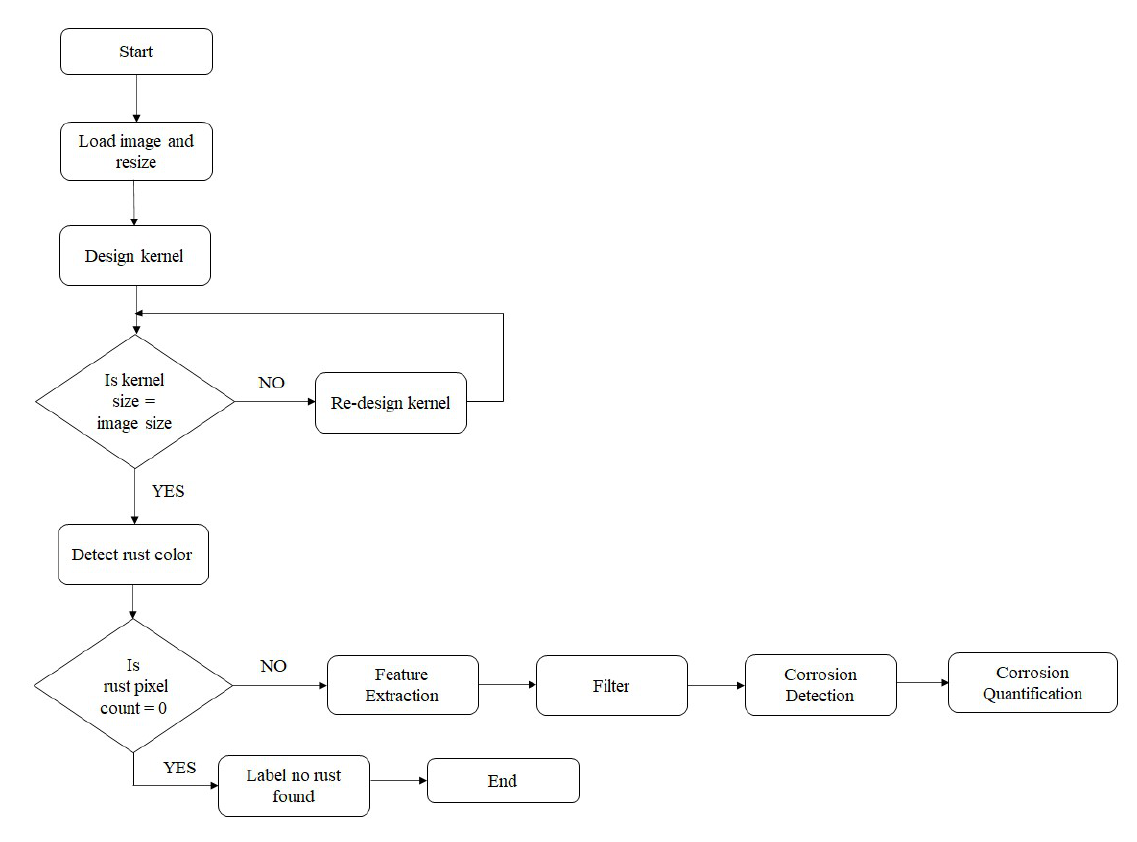
Figure 1. Corrosion detection and quantification